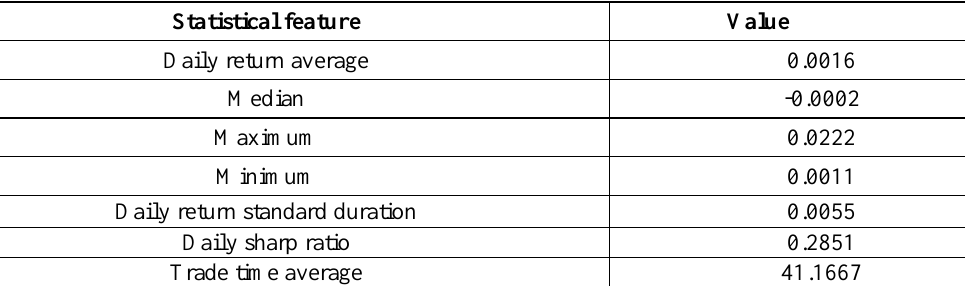
Table 6. Statistical description for the resulted